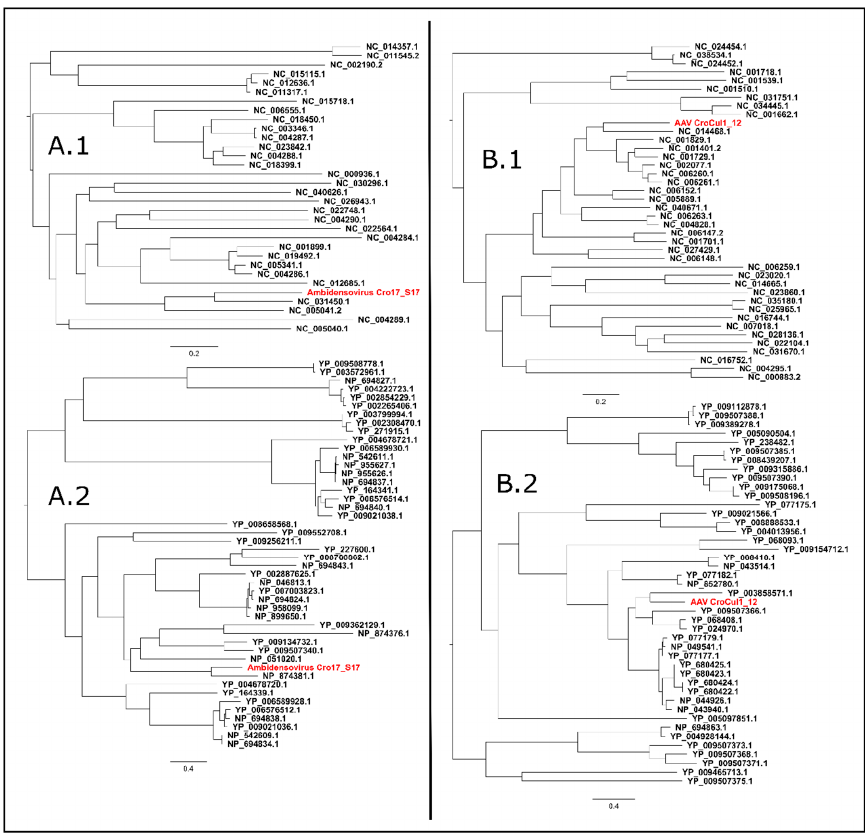
Figure 2. Phylogenetic clustering of Ambidensovirus Cro17_S17 ( A ) and Adeno-associated virus AAV CroCul1_12 ( B ) based on the complete genome nucleotide ( A.1 , B.1 ) and the NS1/Rep amino acid CroCul1_12( B )basedonthecompletegenomenucleotide( A.1 , B.1 )andtheNS1 /